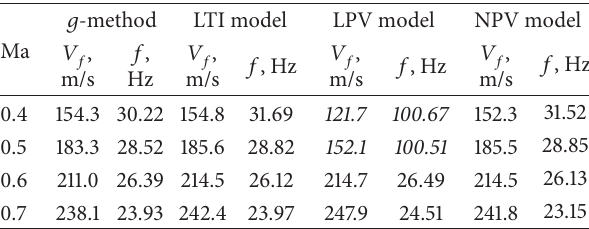
Table 2: Open-loop flutter